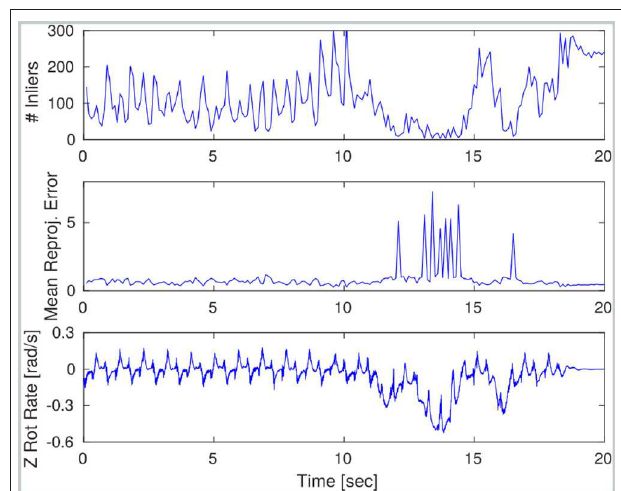
FIGURE 3 | Visual odometry performance during a trotting sequence on HyQ: the robot first trots forward at 0.3m / s and then turns in place sharply over a 5s period. During the initial trotting phase, VO performance is satisfactory. However, image blur causes the number of inliers to fall and mean re-projection error to spike. During this part of the experiment, no VO measurements are incorporated into the main motion